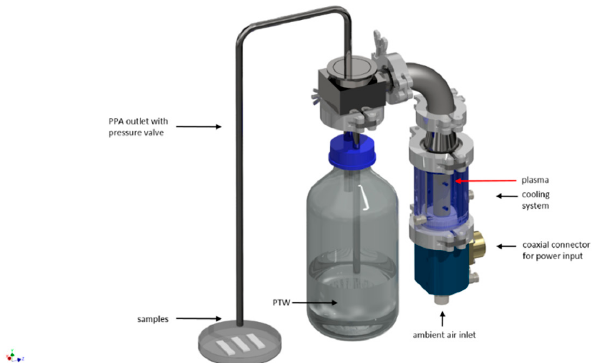
Figure 2. Scheme of the microwave-setup for the generation of PTW (plasma-treated water).